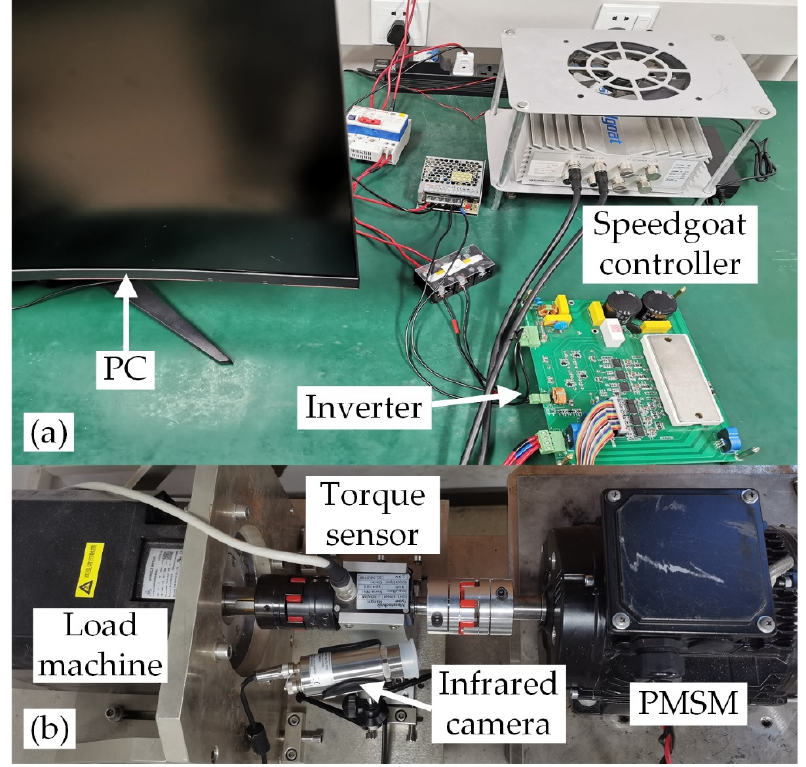
Table 2. Design parameters of employed VSI.